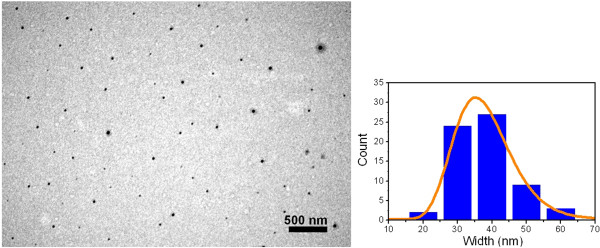
TEM image of the (Er,Yb):Lu2O3 nanocrystals.